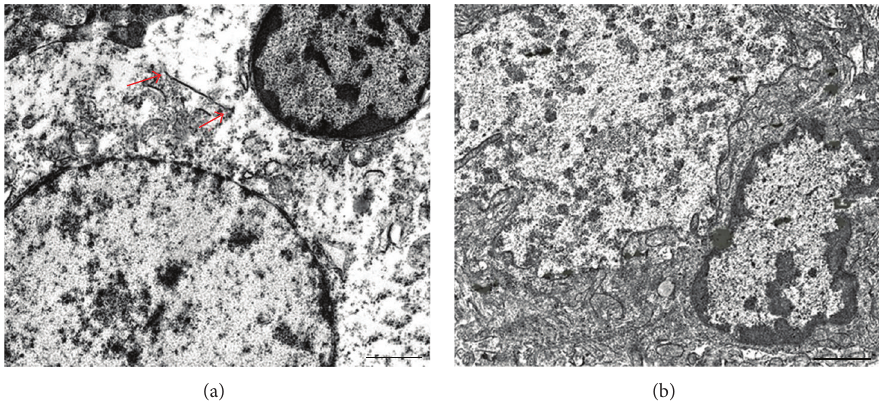
Figure 9: Electron microscope image of heterokaryons. (a) The oligodendrocyte’s nucleus (right) and the neuron’s nucleus (left) are located in the fused cytoplasm of the two cells. The cell membrane, which previously divided the cells, is observed as a fragment (arrows). The chromatin in the oligodendrocyte’s nucleus has divided into heterochromatin (dark accumulations at the nuclear membrane and in the center of the nucleus) and euchromatin (granulated matter at the larger part of the nuclear area). Euchromatin in olygodendrocyte’s nucleus darker than euchromatin in neuron’s nucleus. (b) The oligodendrocyte’s nucleus (right) and the neuron’s nucleus (left). Euchromatin in the oligodendrocyte’s nucleus has the same light staining as that in the neuron’s nucleus. The scale bar is 2 𝜇